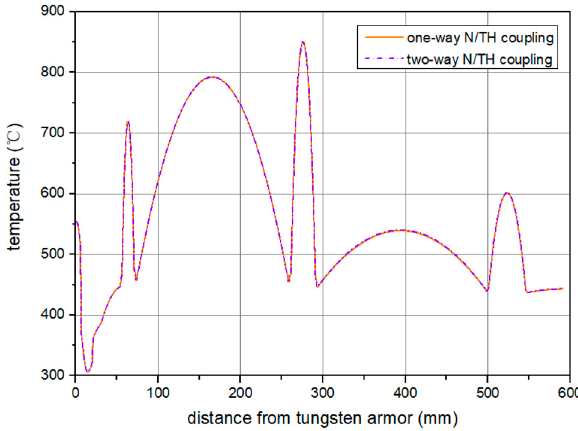
Figure 18. Comparison of the temperature distribution along the radial direction.